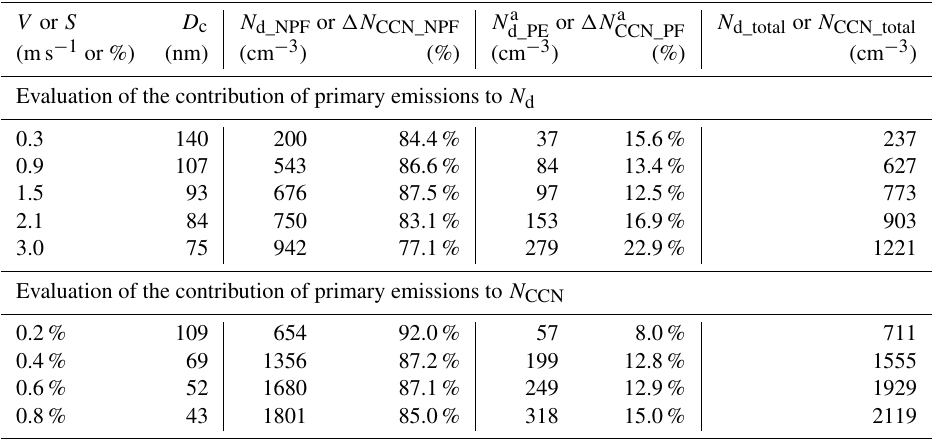
Table 2. Quantitative evaluation of the contribution of primary emissions to N d and N CCN . V or S Evaluation of the contribution of primary emissions to N d 0.3 140